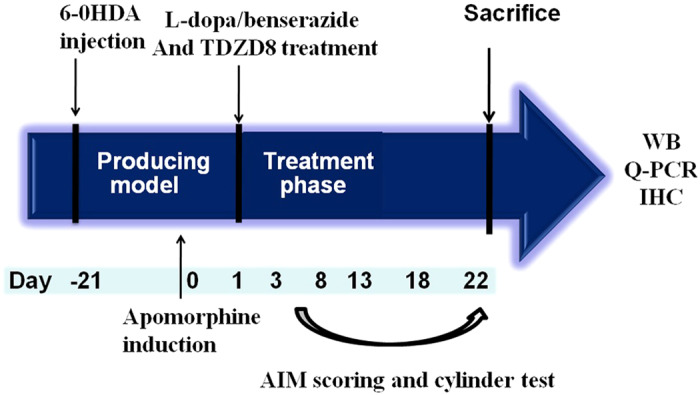
The protocol of the experiment.SD rats (36) were unilaterally injected with 6-OHDA in the medial forebrain bundle (MFB). Contralateral turning behaviours after apomorphine injection were tested 21 days later. Apomorphine-induced rotations exceeded 7 turns/min were enrolled in the next experiment. Rats in the LID group (n = 8) were administrated once-daily (9:00 am) with L-dopa (25 mg/kg, i.p.) plus benserazide (6.25 mg/kg, i.p.) for 3 weeks; Rats in the TDZD8 groups were further divided into two groups, namely TDZD8 low dose group (TDZD8-L, 1 mg/kg, n = 8) and TDZD8 high dose group (TDZD8-H, 2 mg/kg, n = 8). Rats received TDZD8 also one time per day for 3 weeks. Additionally, rats in the PD group (n = 8) and sham group (n = 4) were treated physiological saline for 3 weeks. AIMs were evaluated during this period at days 2, 7, 12, 17 and 21. The animals were sacrifced 2 h after the last injection for western blot and Q-PCR. TDZD8: 4-Benzyl-2-methyl-1,2,4-thiadiazolidine-3,5-dione; i.p.: intraperitoneal.